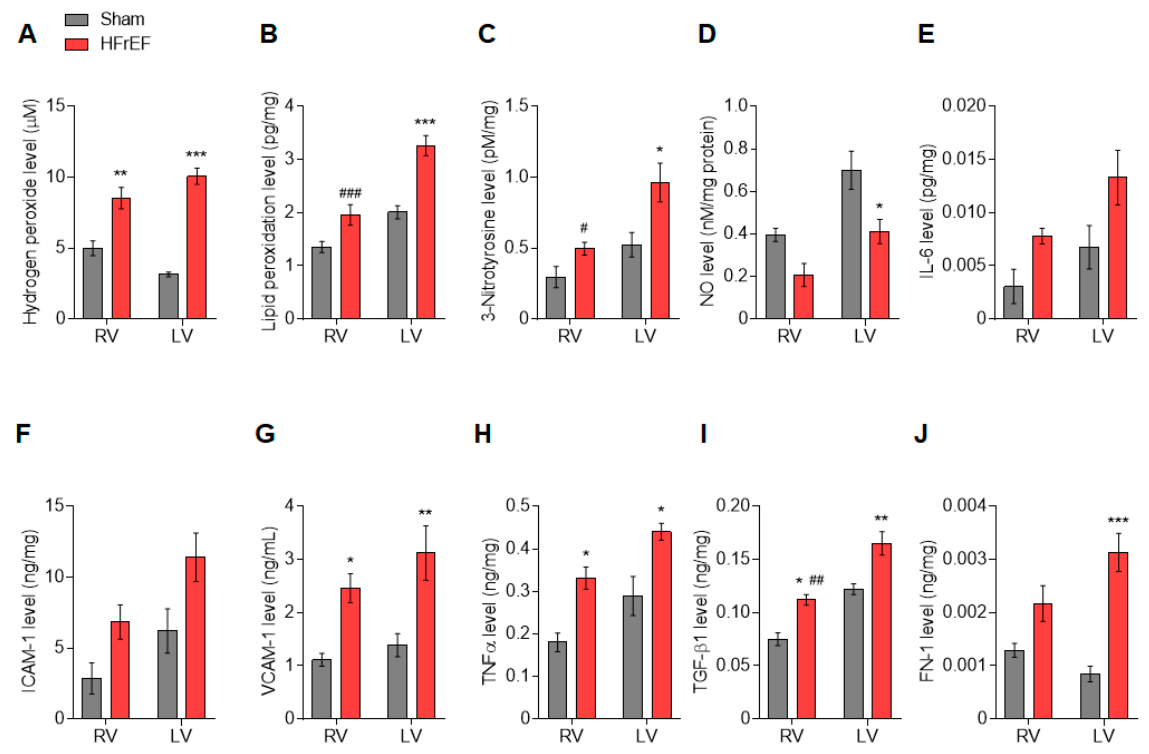
Figure 1. Interventricular differences of oxidative stress and inflammation in the post-ischemic rat heart. Concentration levels of hydrogen peroxide ( A ), lipid peroxidation ( B ), 3-Nitrotyrosine ( C ), nitric oxide (NO; D ), interleukin 6 (IL-6; E ), intercellular cell adhesion molecule-1 (ICAM-1; F ), vascular cell adhesion molecule-1 (VCAM-1; G ), tumor necrosis factor alpha (TNF α ; H ), transforming growth factor-beta 1 (TGF- β 1; I ), and fibronectin-1 (FN-1; J ) are shown in the right ventricle (RV) and left ventricle (LV) of post-ischemic (HFrEF) and Sham-operated (Sham) rat hearts. Data are shown as mean ± SEM; n = 4–5 sample/group. * p < 0.05, ** p < 0.01, *** p < 0.001 HFrEF vs. Sham (same ventricle); # p < 0.05, ## p < 0.01, ### p < 0.001 RV vs. LV (same group).